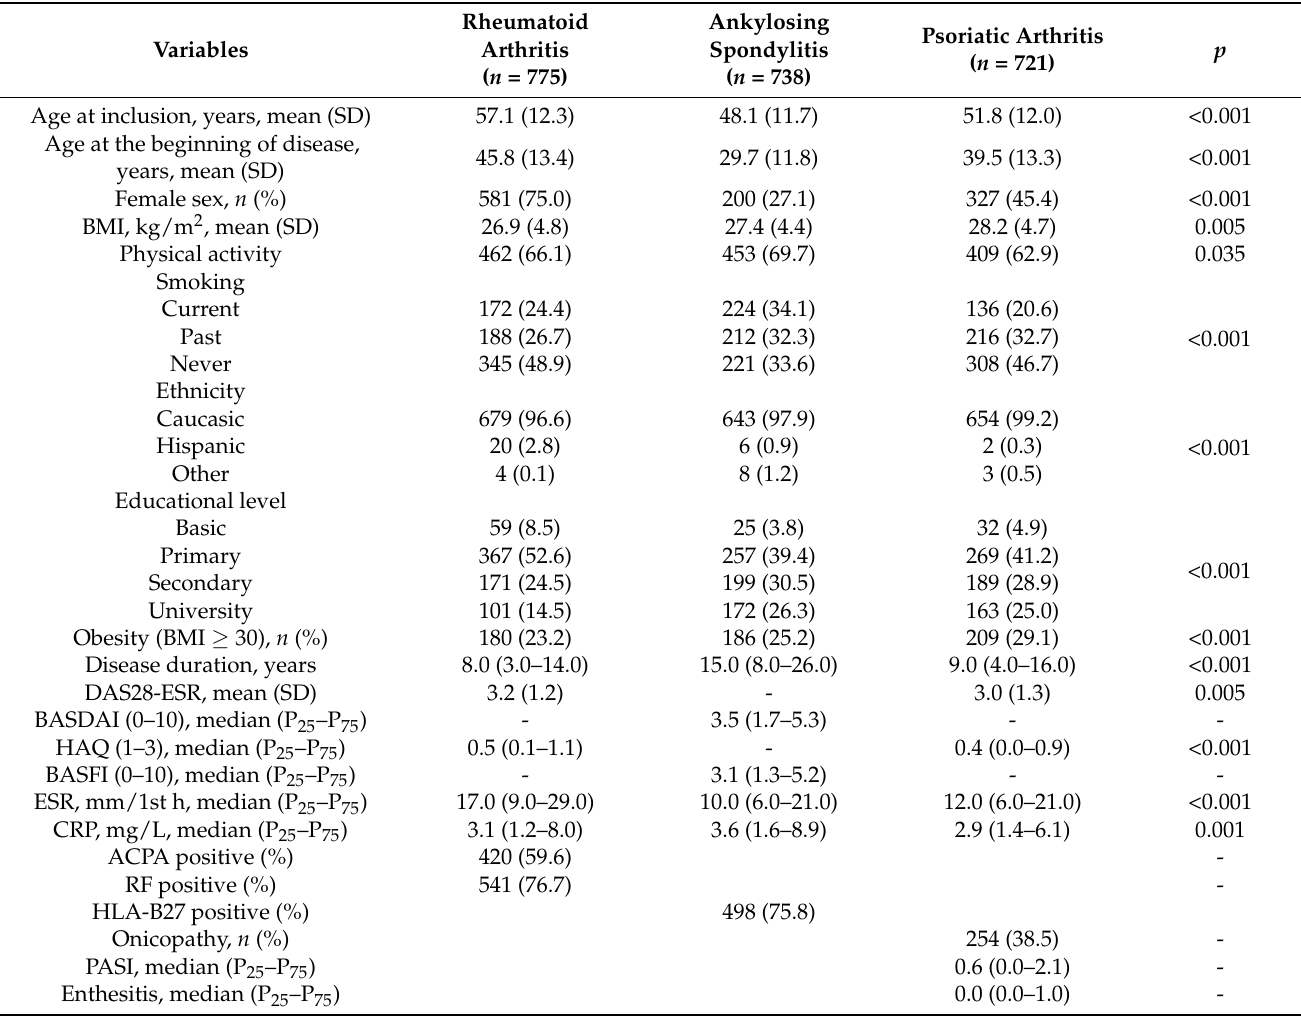
Table 1. Main demographic, lifestyle, and clinical characteristics of the patients included in the